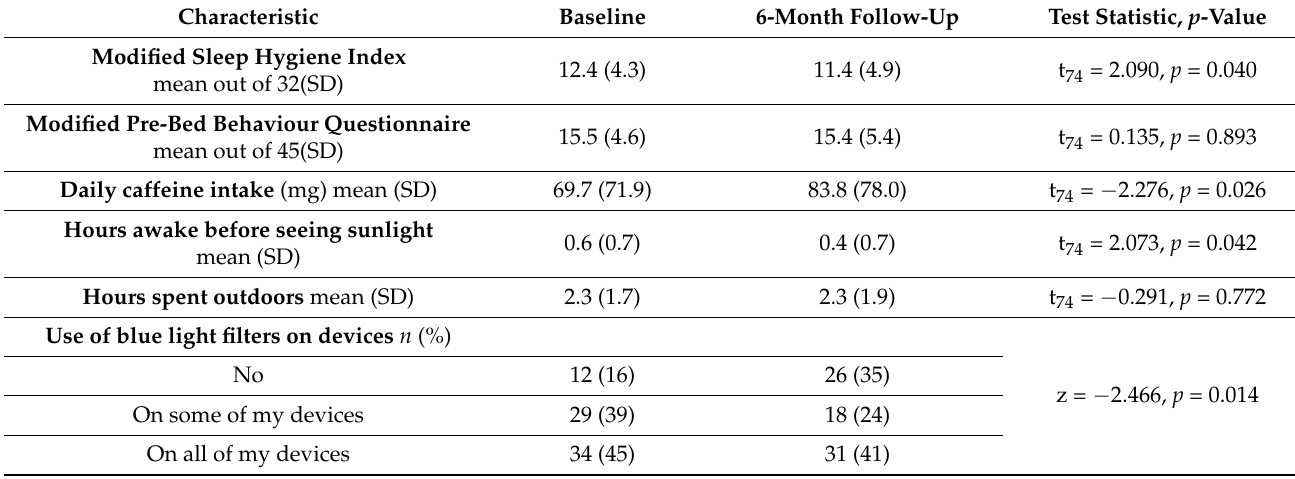
Table 3. Sleep behaviours before and 6 months after completion of a sleep and circadian education course ( n =